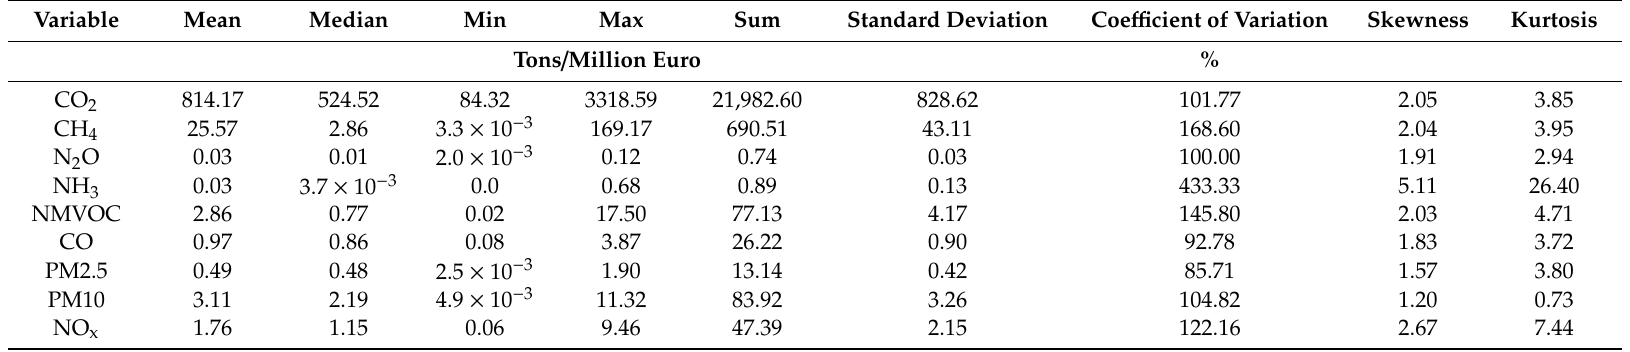
Table 5. Basic statistical parameters of the emissions of studied substances in relation to the gross value added (GVA) by the mining and quarrying sector (own